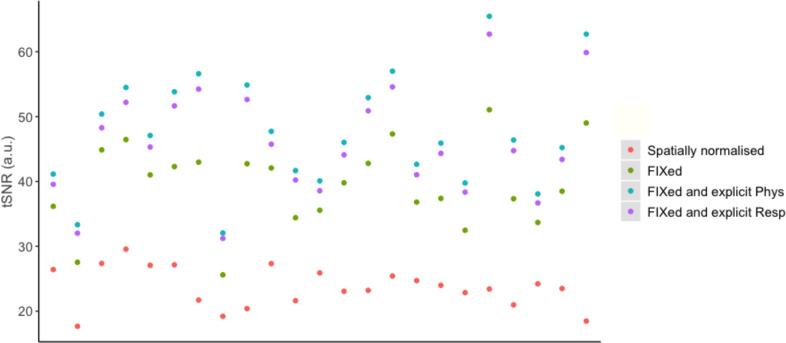
Comparison of the temporal signal-to-noise ratio (tSNR) per participant across fMRI pipelines.Note: Compared to the ‘spatially normalized’ pipeline, the ‘FIX’ pipeline provided a sizable gain in tSNR, while including explicit physiological time series provided a modest tSNR increase (median ‘FIXed’=39.78 (IQR = 35.862, 42.88), median ‘FIXed + explicit Resp’=44.74 (IQR = 39.893, 51.931), median ‘FIXed + explicit Phys’=46.39 (IQR = 41.402, 54.159), median ‘Spatially normalized’=23.48 (IQR = 21.657, 26.156)), but at the cost of removing 22 statistical degrees of freedom This is also reflected in the intraclass correlation coefficient between the pipelines: spatially normalized versus FIXED: ICC = 0.443; FIXED versus FIXED + explicit Resp: ICC = 0.96; and FIXED + explicit Resp versus FIXED + explicit Phys: ICC = 1.00.These ICC values show a high level of similarity between the tSNR of the FIXED, FIXED + explicit Resp and FIXED + explicit Phys pipelines.